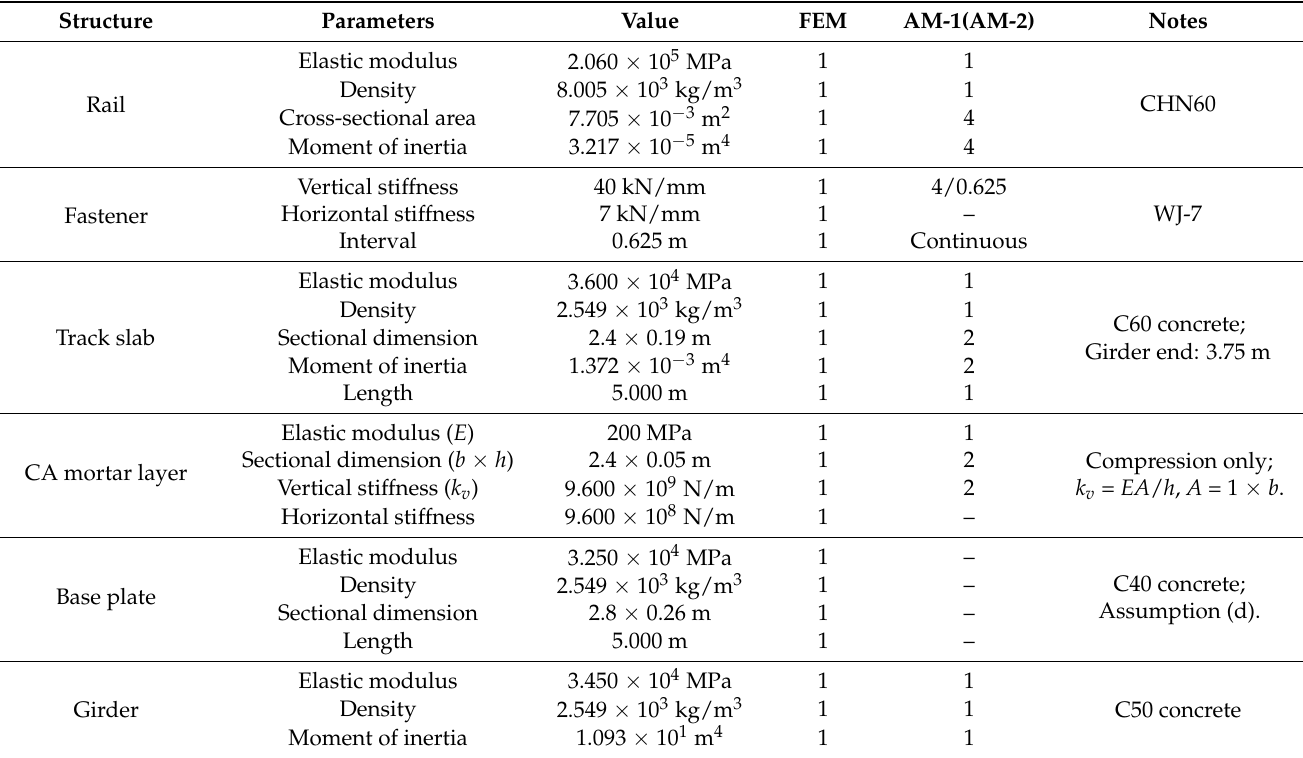
Table 1. Parameters of the unit slab-type ballastless track-bridge system.